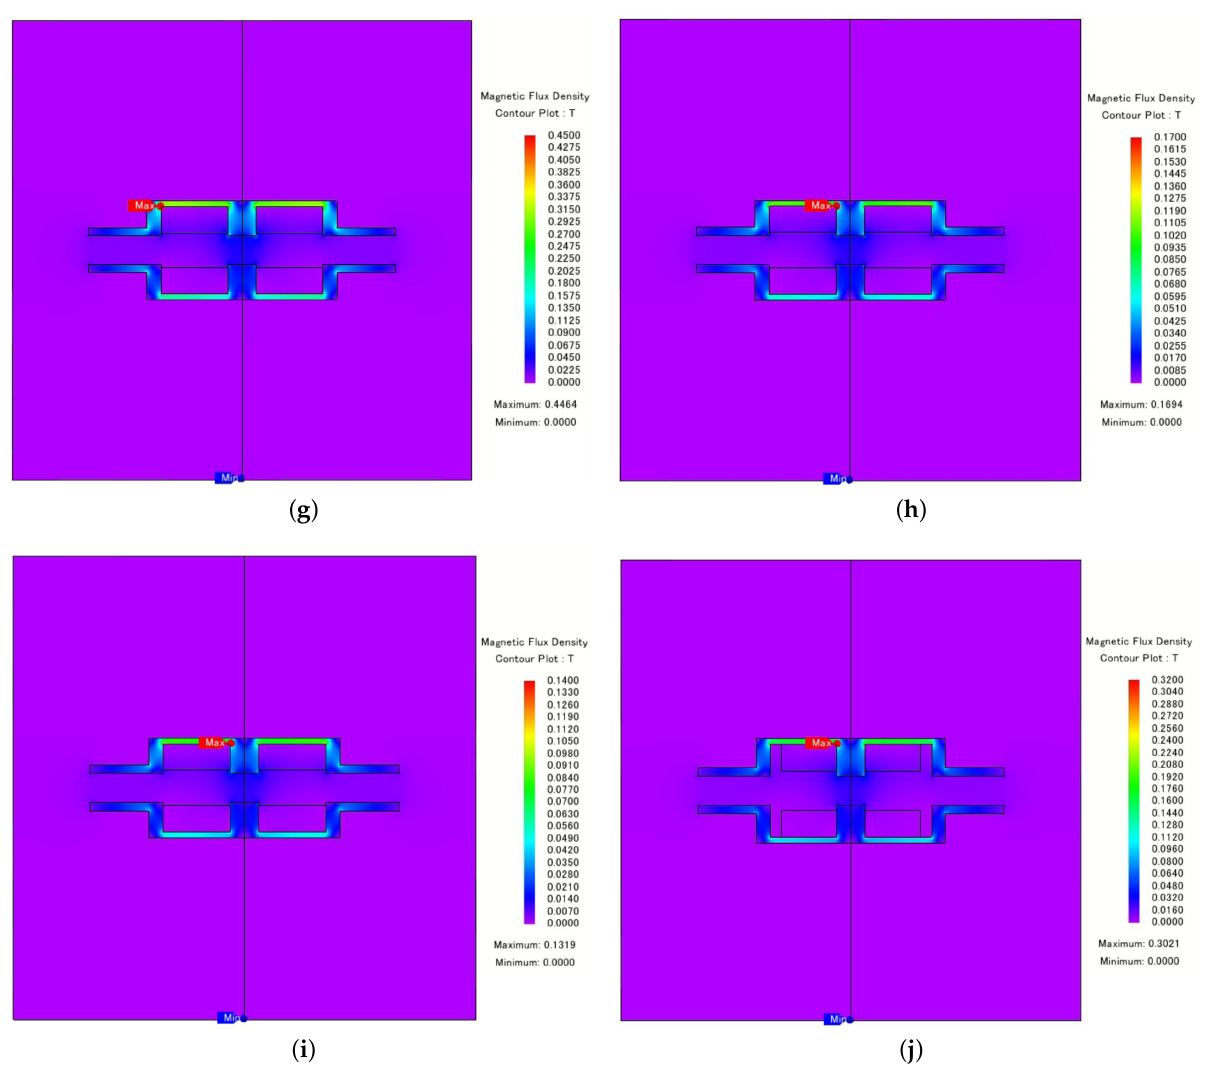
Figure 12. The Pareto front of example 2 at ( a ) case 130, ( b ) case 193, ( c ) case 166, ( d ) case 196, ( e ) case